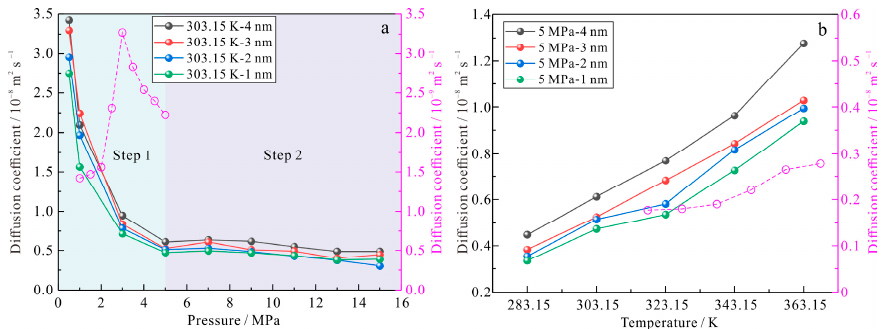
Figure 13. Diffusion coefficients for FK–3 coal, calculated from molecular dynamics simulations, as function of methane pressure ( a ) and temperature ( b ). Data from Liu et al. [37] are plotted as dashed lines for comparison.